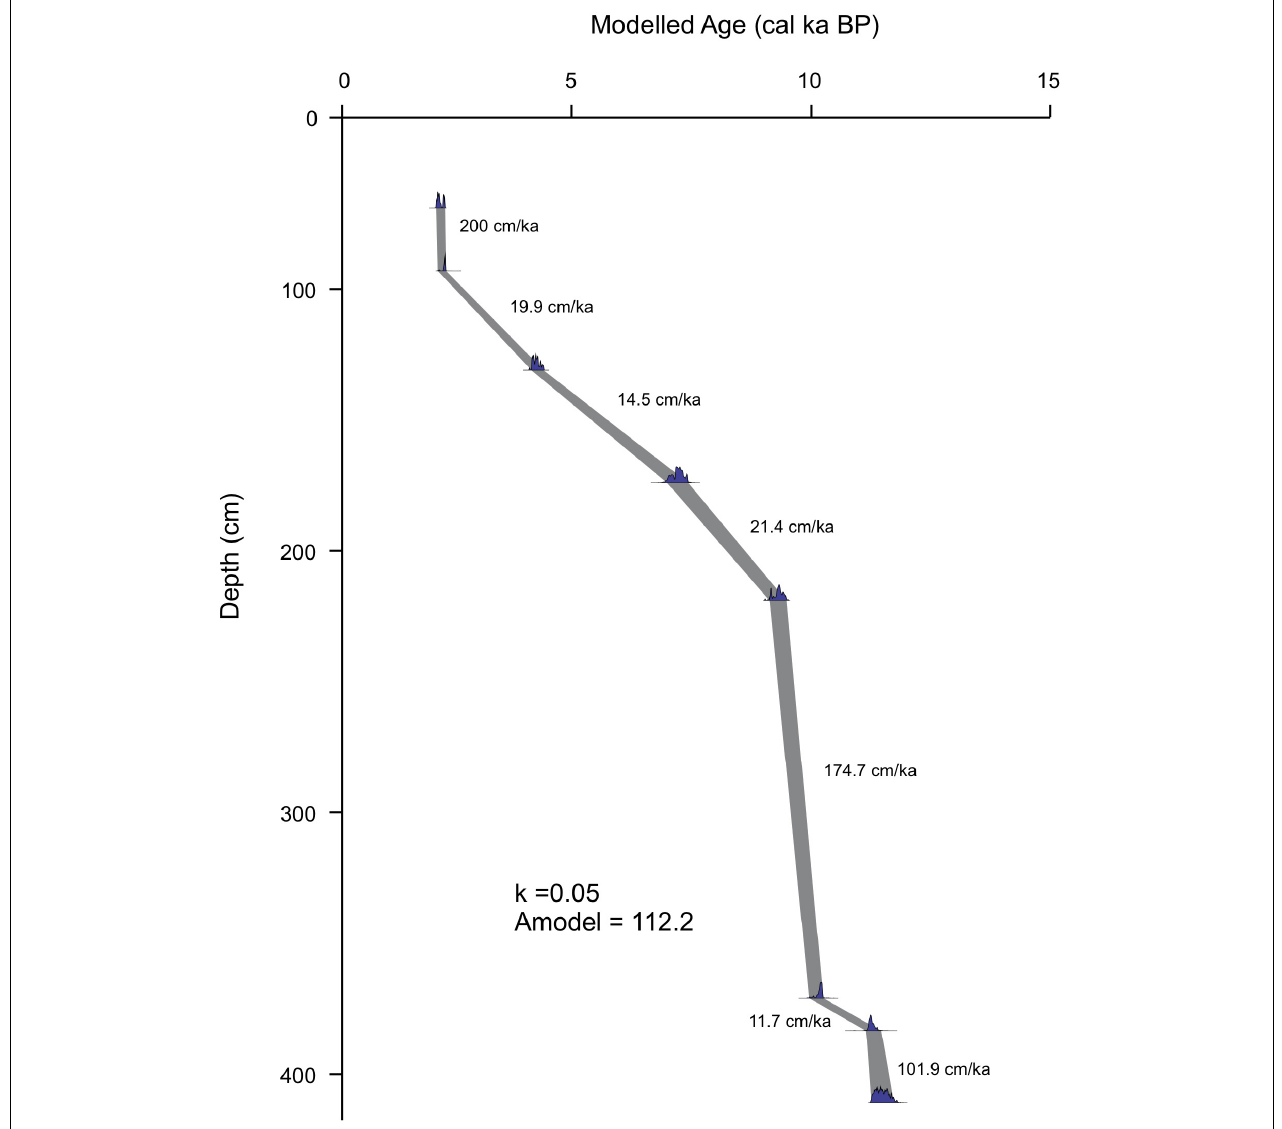
FIGURE 4 | A Bayesian age-depth model for the Holocene deposits of the sediment core (COA-N2-2019) with an agreement index of 112.2%. Tie points with uncertainties of 40–130 years and depositional rates of 0.02–0.35 cm/yr assigned chronology to the 73 sediment layers analyzed for mineralogy and geochemistry for the sub-millennial-scale paleoenvironmental